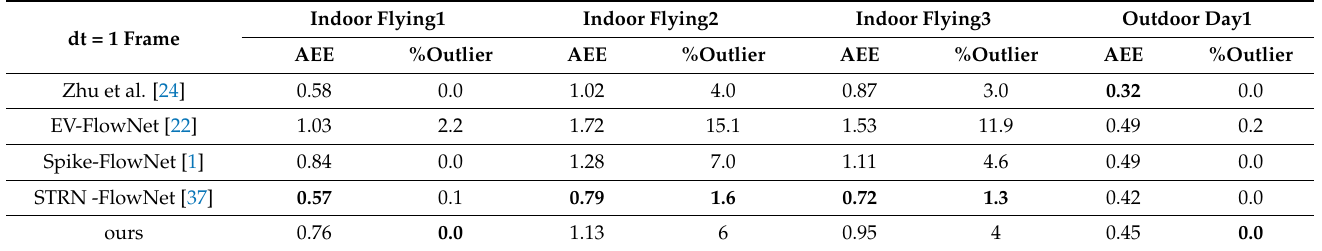
Table 1. The quantitive results compared with the recent works [1,22,24,37] on event-based optical flow